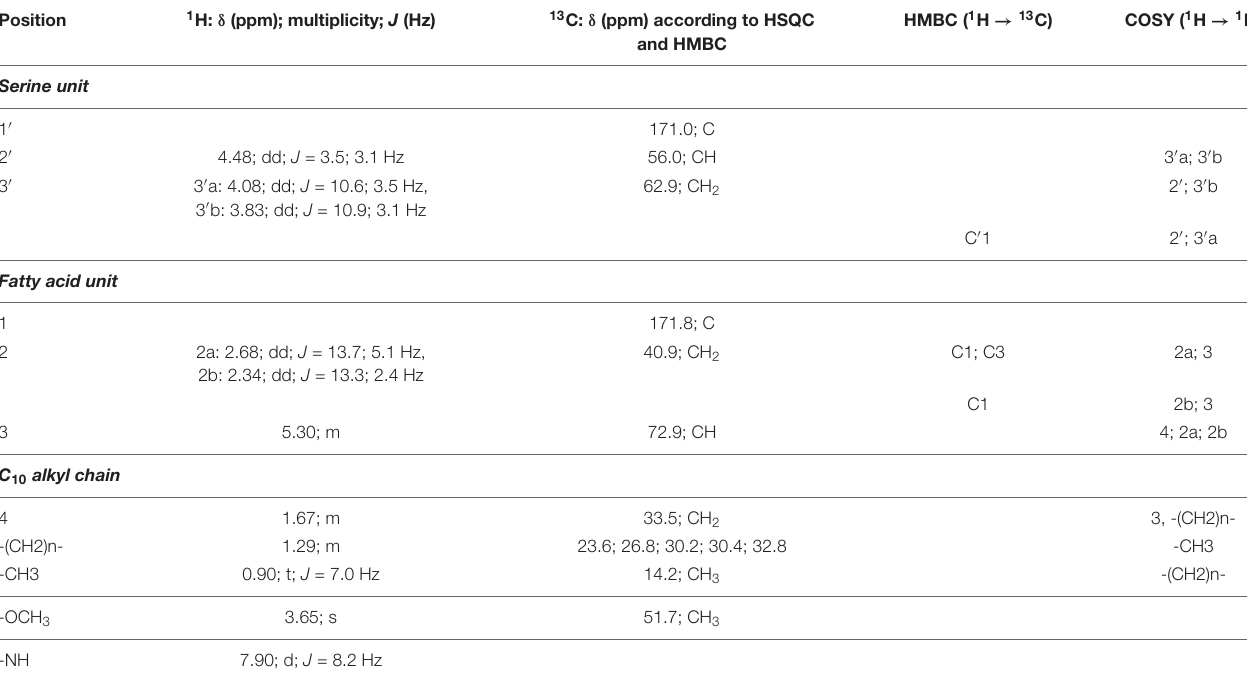
TABLE 1 | NMR data (CD 3 OD) obtained from fraction 3 spectrum and corresponding to serratamolides. Position